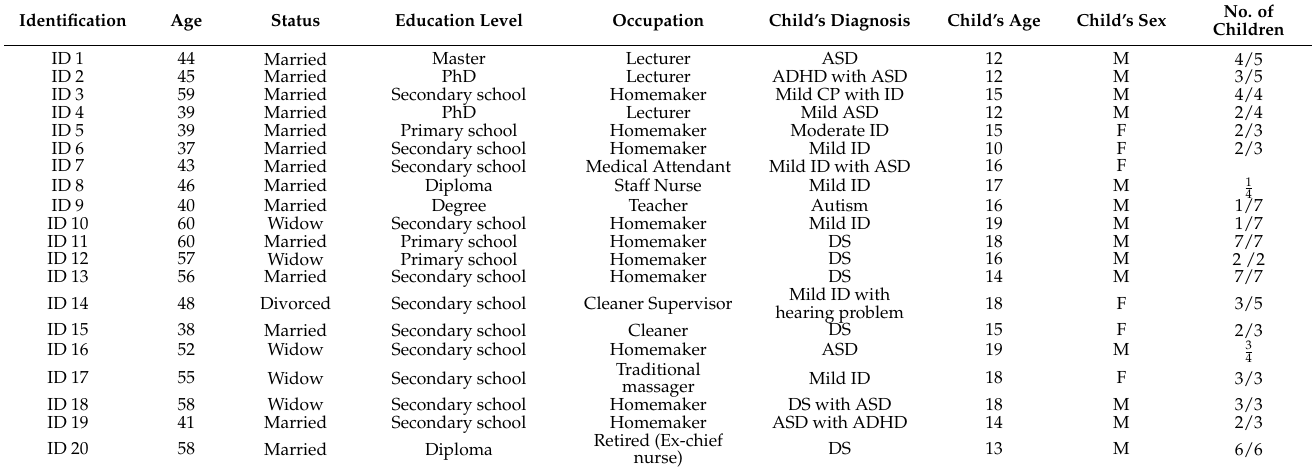
Table 1. Characteristics of the mothers and children with intellectual disabilities (n = 20).